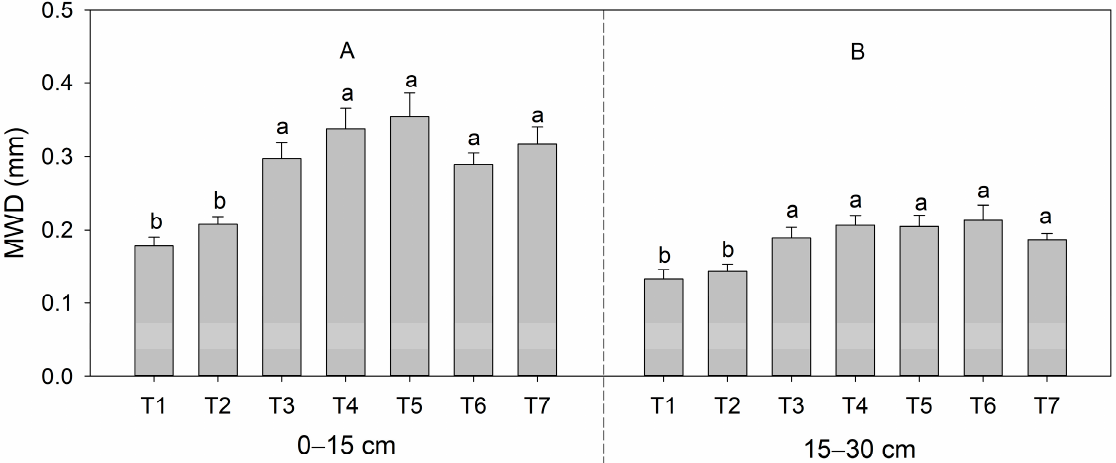
Figure 4. Mean weight diameter (MWD) at 0–15 and 15–30 cm depths as affected by different treatments in 2020 after 12 years of annual fertilization. T1: N application by farmers (240 kg N ha − 1 ); T2: optimized N management (Nopt); T3: biochar + Nopt; T4: straw + Nopt; T5: manure + Nopt; T6: compost + Nopt; T7: biogas residue + Nopt. Lower-case letters indicate significant differences among treatments at a specific soil depth at p < 0.05 level. Capital letters indicate significant differences between the two soil depths at p < 0.05 level.